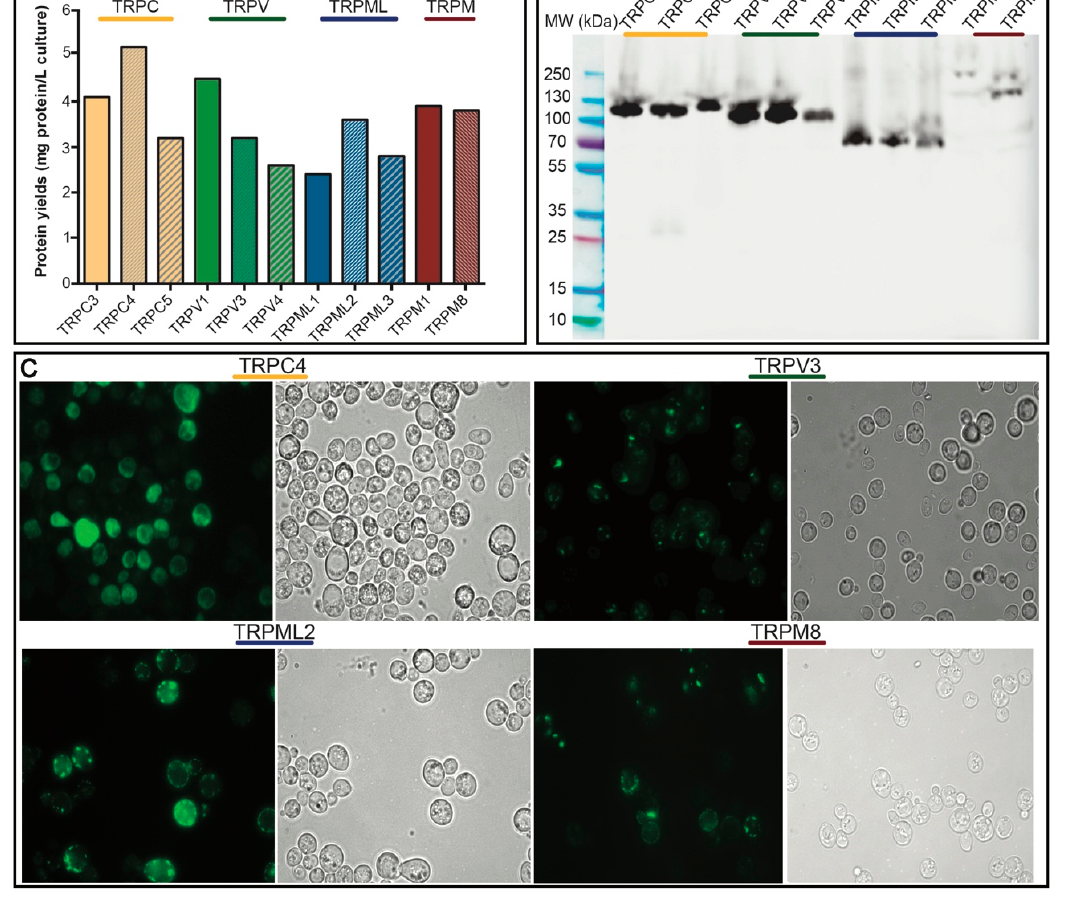
Figure 3. Expression and localization of human TRP channels. Data are shown for S. cerevisiae cell cultures grown in 2-L scale for 48 h at 15 ◦ C. ( A ) Estimates of protein production levels of 11 human TRP-channels. Measured whole-cell GFP fluorescence was converted to the protein amount and the predicted yield is shown as mg per liter cell of culture. ( B ) In-gel GFP fluorescence of SDS-PAGE-separated crude membranes containing the different TRP channel targets. The image includes all samples separated on the same gel. ( C ) Live cell bioimaging of yeast cells expressing selected TRP channels. For each target GFP fluorescence and differential interference contrast micrographs are shown. Magnification: 1000 ×